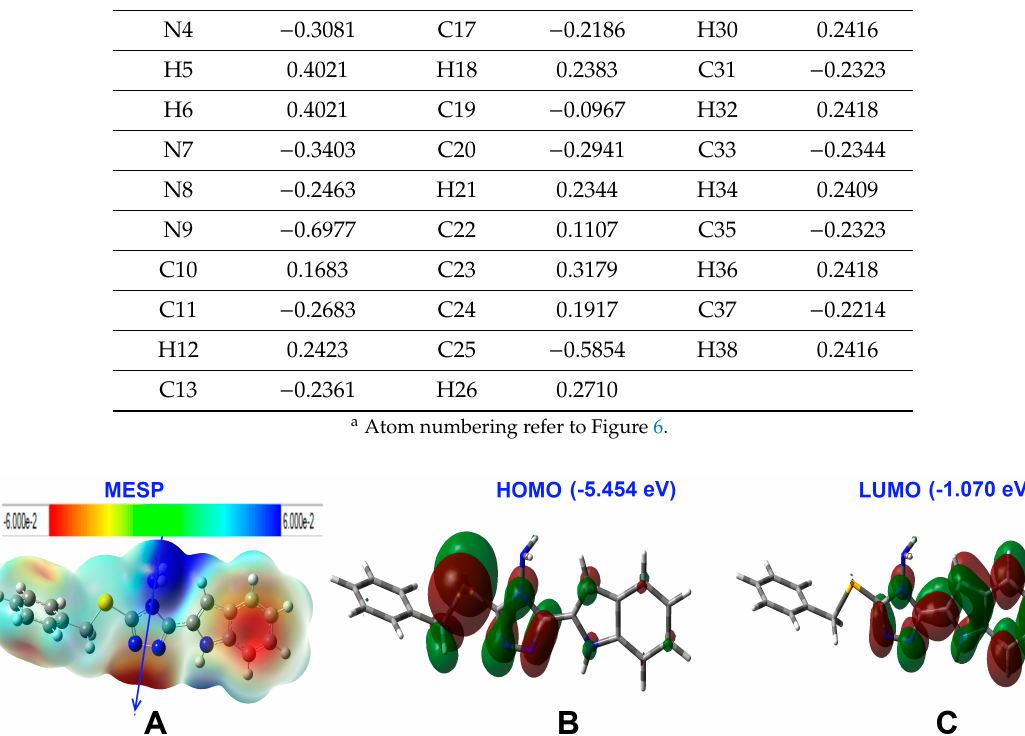
Figure 8. The molecular electrostatic potential (MESP; ( A )), highest occupied (HOMO; ( B )) and lowest unoccupied molecular orbitals (LUMO; ( C )) of 2